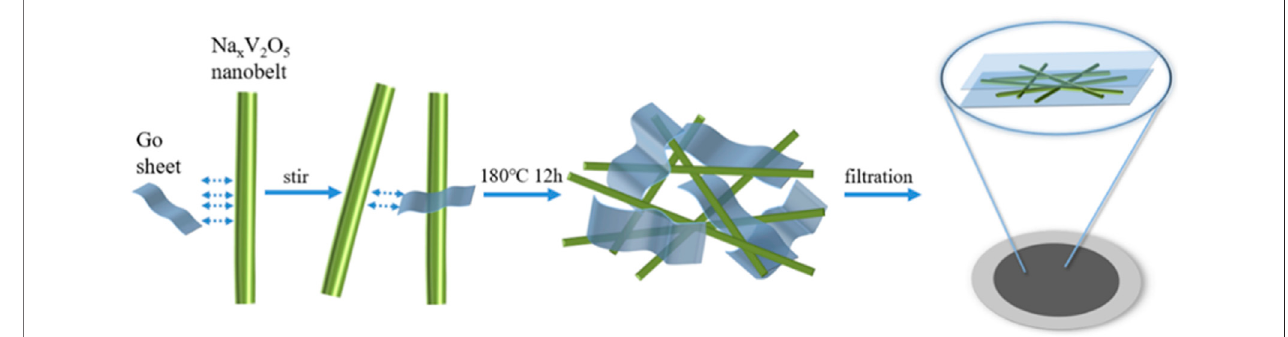
FIGURE 1 | Schematic illustration of the as-prepared Na x V 2 O 5 /rGO fi lm.